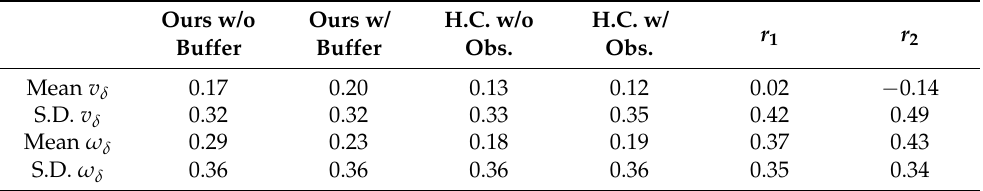
Table 4. Experiments in simulated